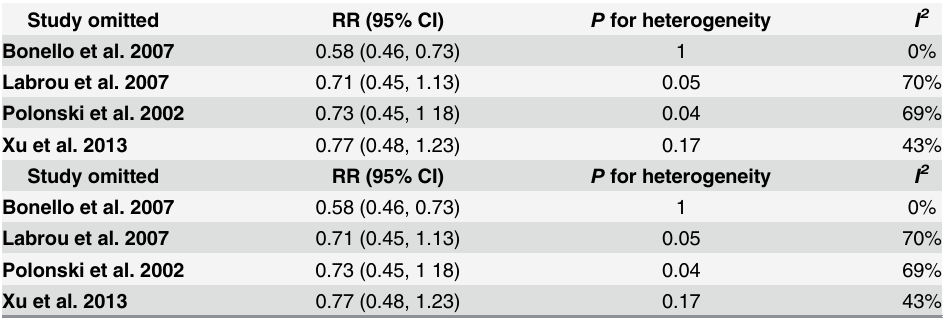
Table 4. Sensitivity Analysis of the Incidence of cTnI > 2 Times the Upper Limit of Normal. Study omitted RR (95% CI) P for